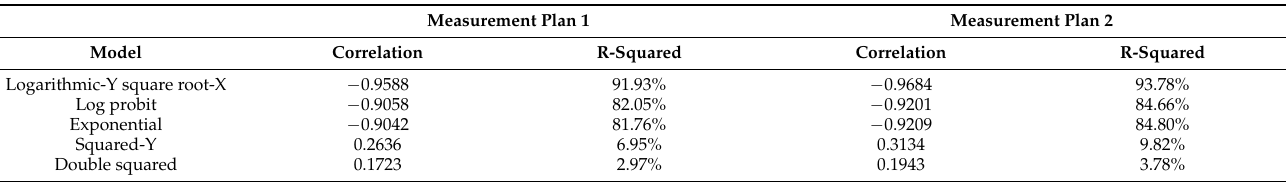
Table 4. Comparison of Alternative